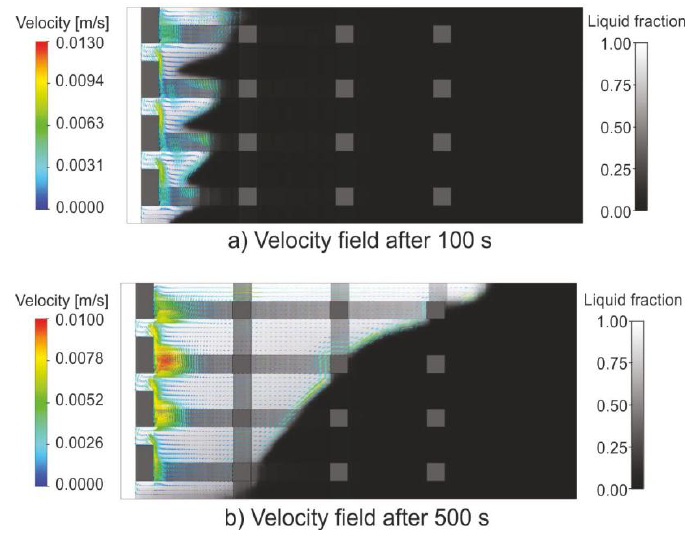
Figure 6. Vector plot of the liquid velocity of the molten PCM at different time steps.